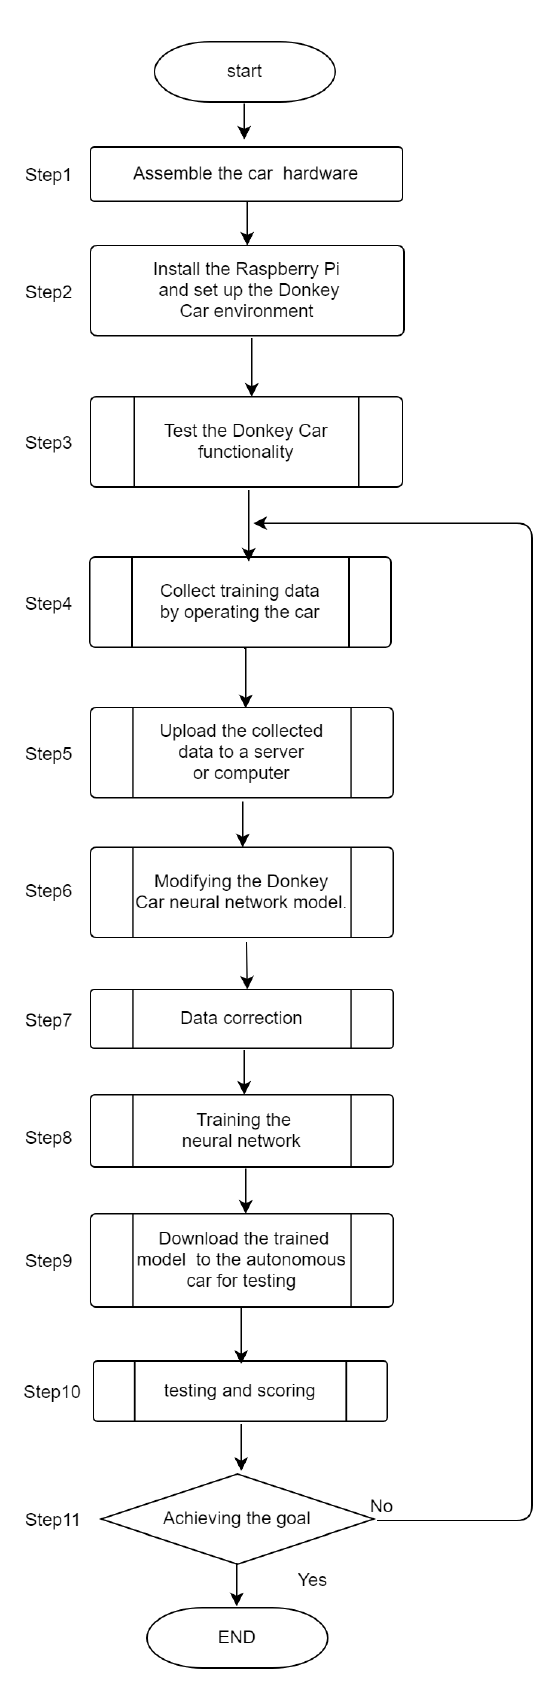
Figure 13. A flow chart depicting the process of course execution.